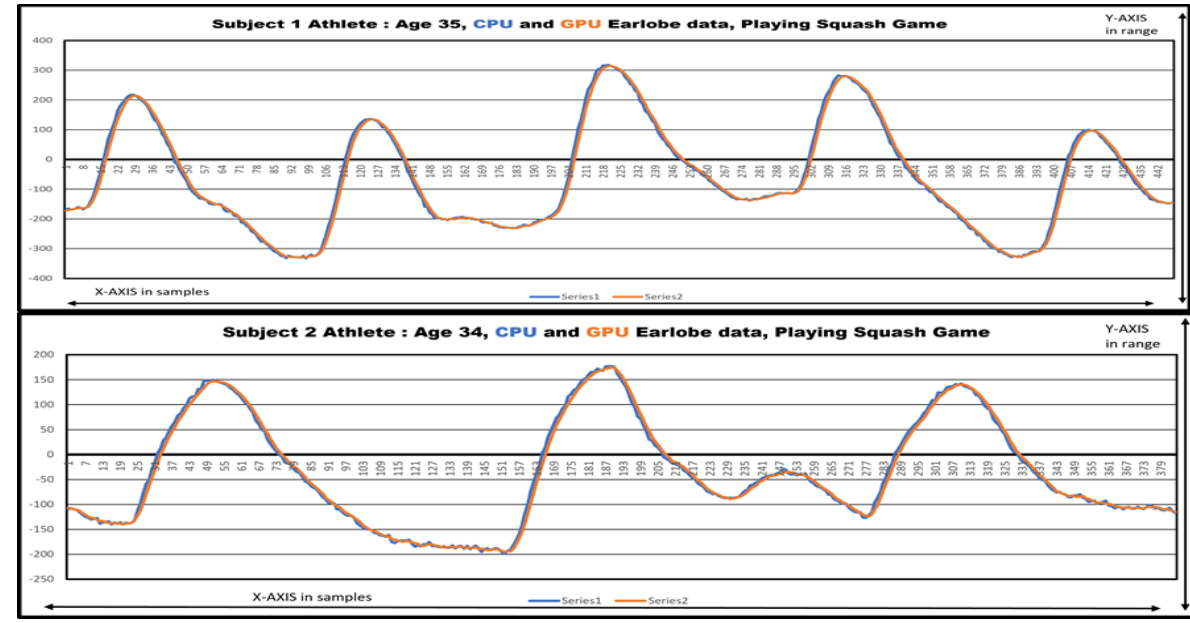
Figure 20. Squash Players’ Earlobe data computed on a CPU and GPU while playing. Figure 21 showcases the observations to demonstrate the atrial and ventricular data. The atrial data for a patient were discussed earlier but the computed ventricular data were placed alongside to show that the signs of RR intervals for ventricular do not exist, even with rapid and intense heartbeats from the heart. One such scenario is clearly observed in Figure 22, showing a sudden death situation in a few minutes.